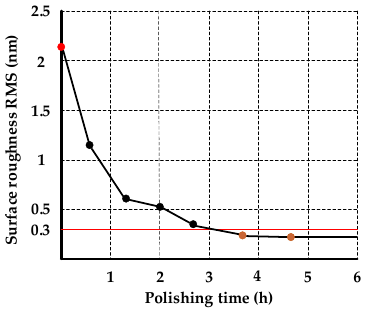
Figure 15. Surface roughness variation of NiP coating during polishing.